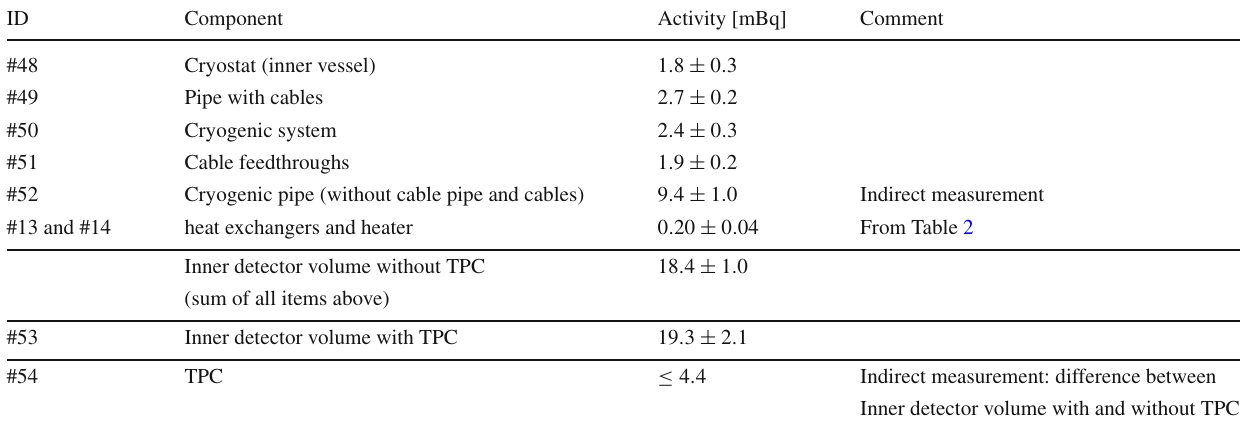
Fig. 1 Schematic setup of XENON1T (not to scale). The colors indicate different sub-components and are also used in Fig. 2, which shows their individual contributions to the overall 222 Rn rate Table 8 Results from measurements of several subsystems of the XENON1T setup. The cryogenic pipe and the TPC were not measured directly. Their 222 Rn emanation rates were inferred indirectly by subtracting the results from two measurements,